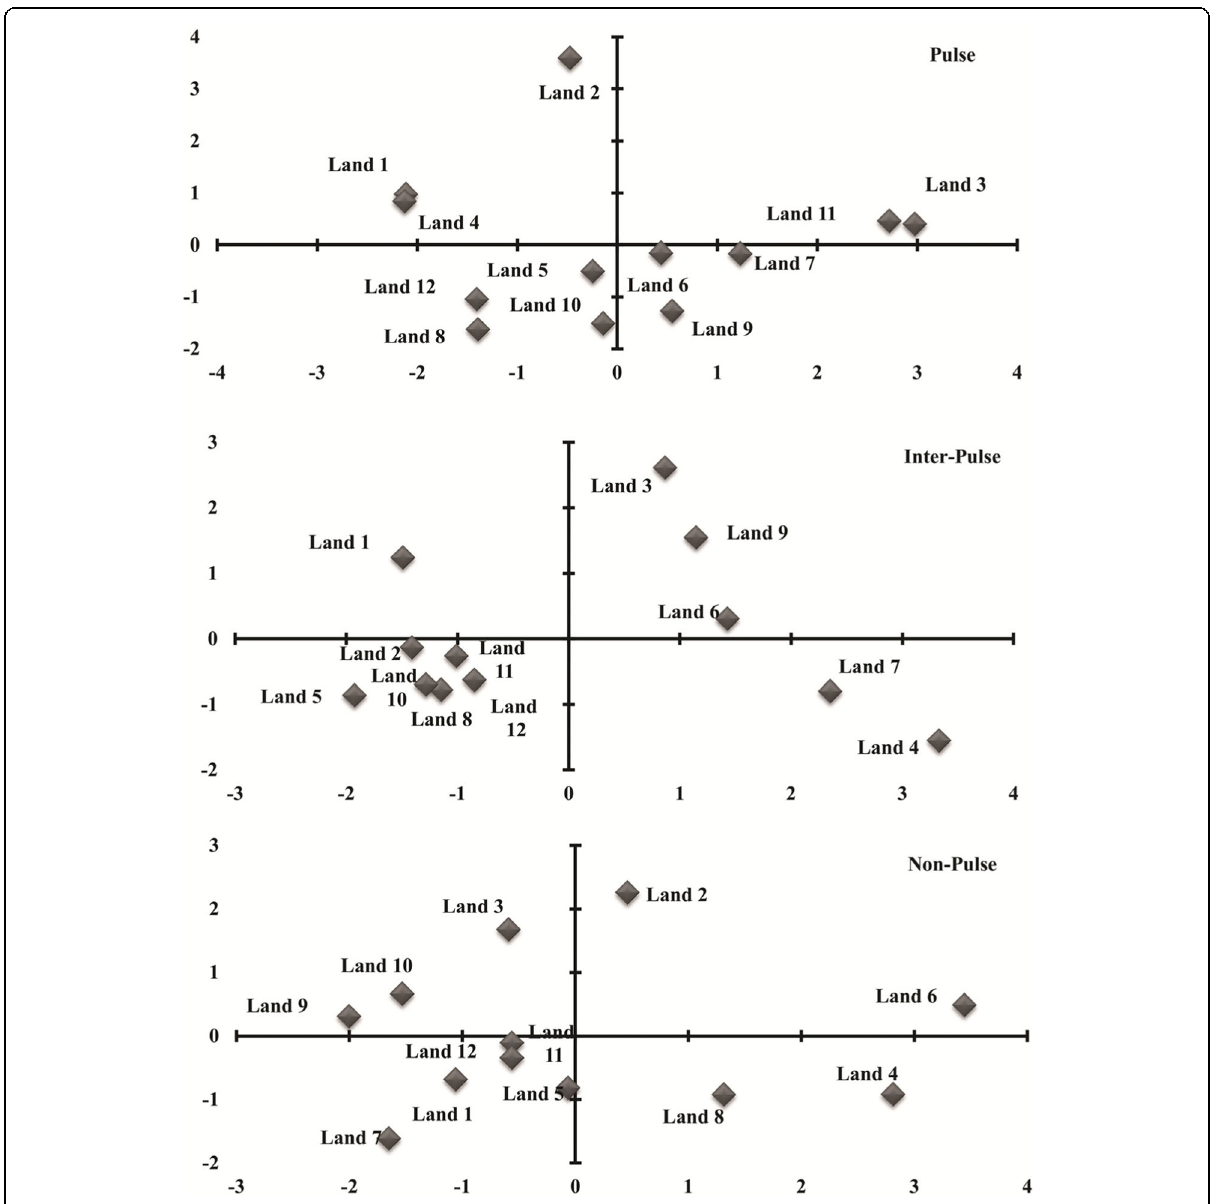
Fig. 2 Principal component analysis for observation used for various indices during different pulse